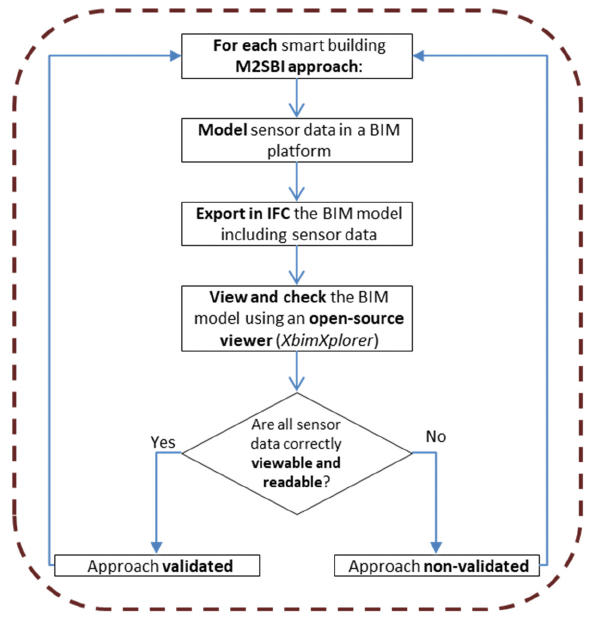
Figure 4. Solution validation methodology.